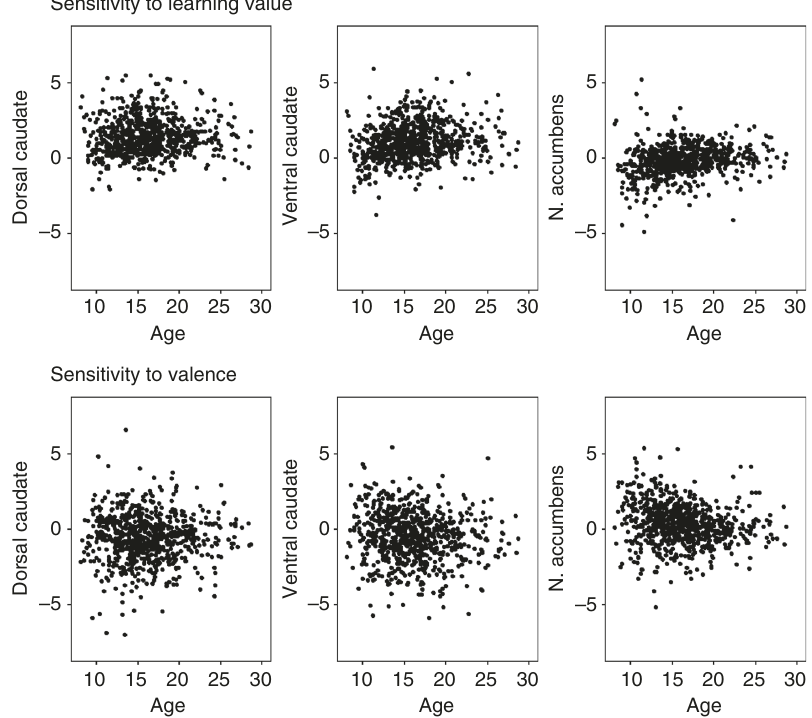
Fig. 2 Individual data at three time points for neural activity in dorsal caudate (center-of-mass coordinates ( x , y , z ): 1, 7, 15), ventral caudate (0, 16, 2), and nucleus accumbens ( − 1, 12, − 7) for sensitivity to informative value (learning > application) and sensitivity to valence (positive > negative